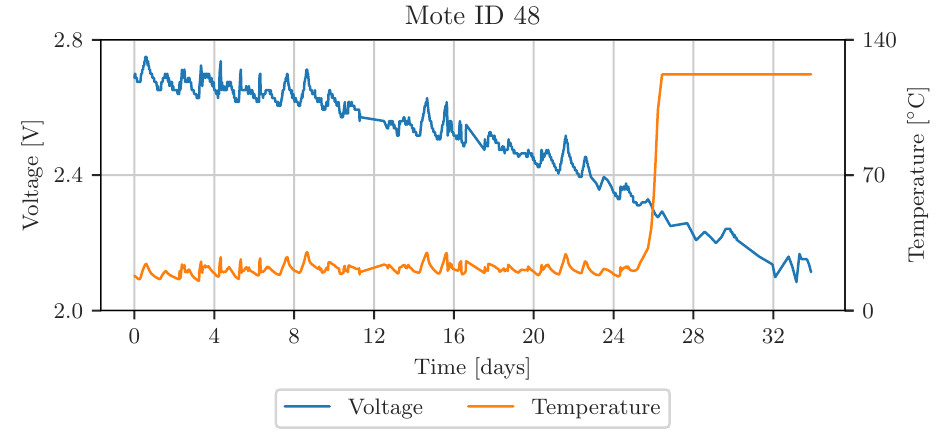
Figure 8. Supply voltage dependency of temperature measurement from sensor mote ID